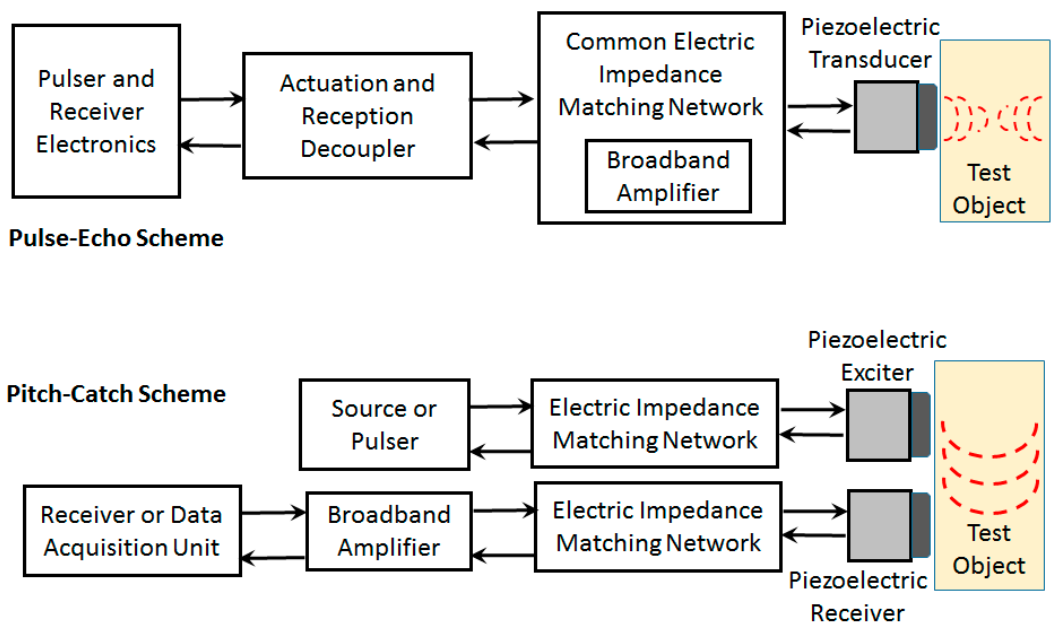
Figure 6. Electric impedance matching schemes for ultrasonic nondestructive evaluation system operating in pulse-echo and pitch-catch configurations.